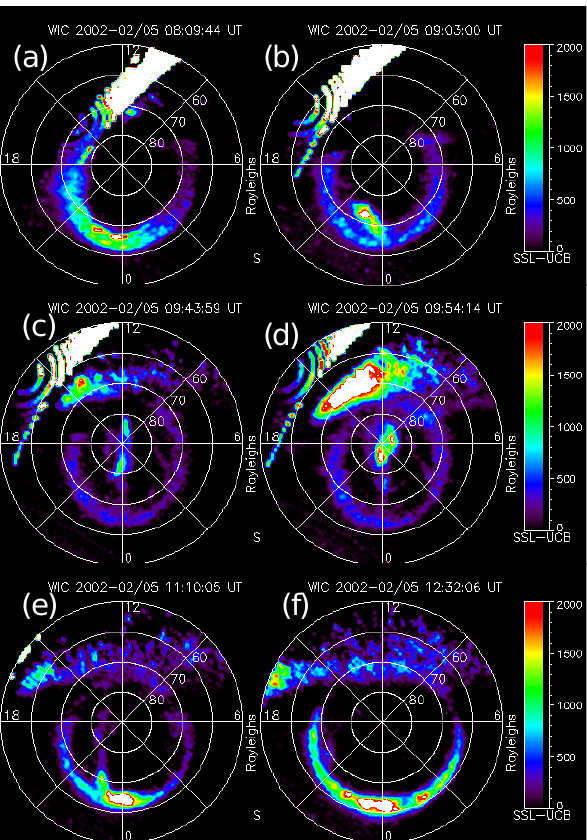
Fig. 2. On 5 February 2002, the Imager for Magnetopause-to- Au- rora Global Exploration (IMAGE) FUV/Wide-band Imaging Cam- era (WIC) instrument provides images of the auroral configuration in the Northern Hemisphere. The data are plotted in magnetic lati- tude and magnetic local time, with noon toward the top and dusk to the left of each